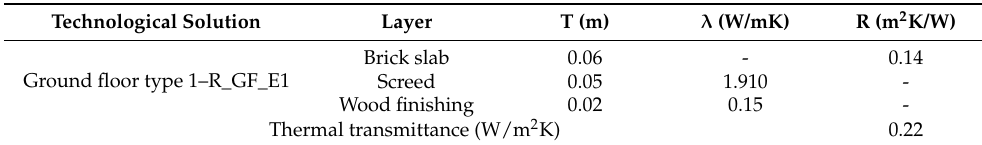
Table A17. Existing ground floor stratigraphy (R_GF_E1).